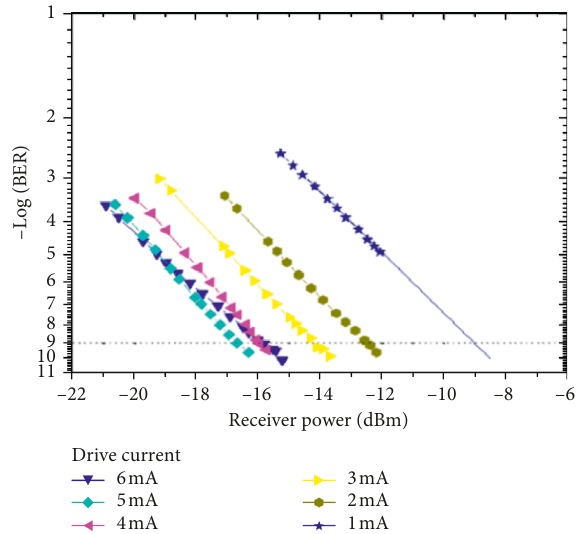
Figure 7: BER measurements showing receiver sensitivity at a bias of 5mA and different modulation settings